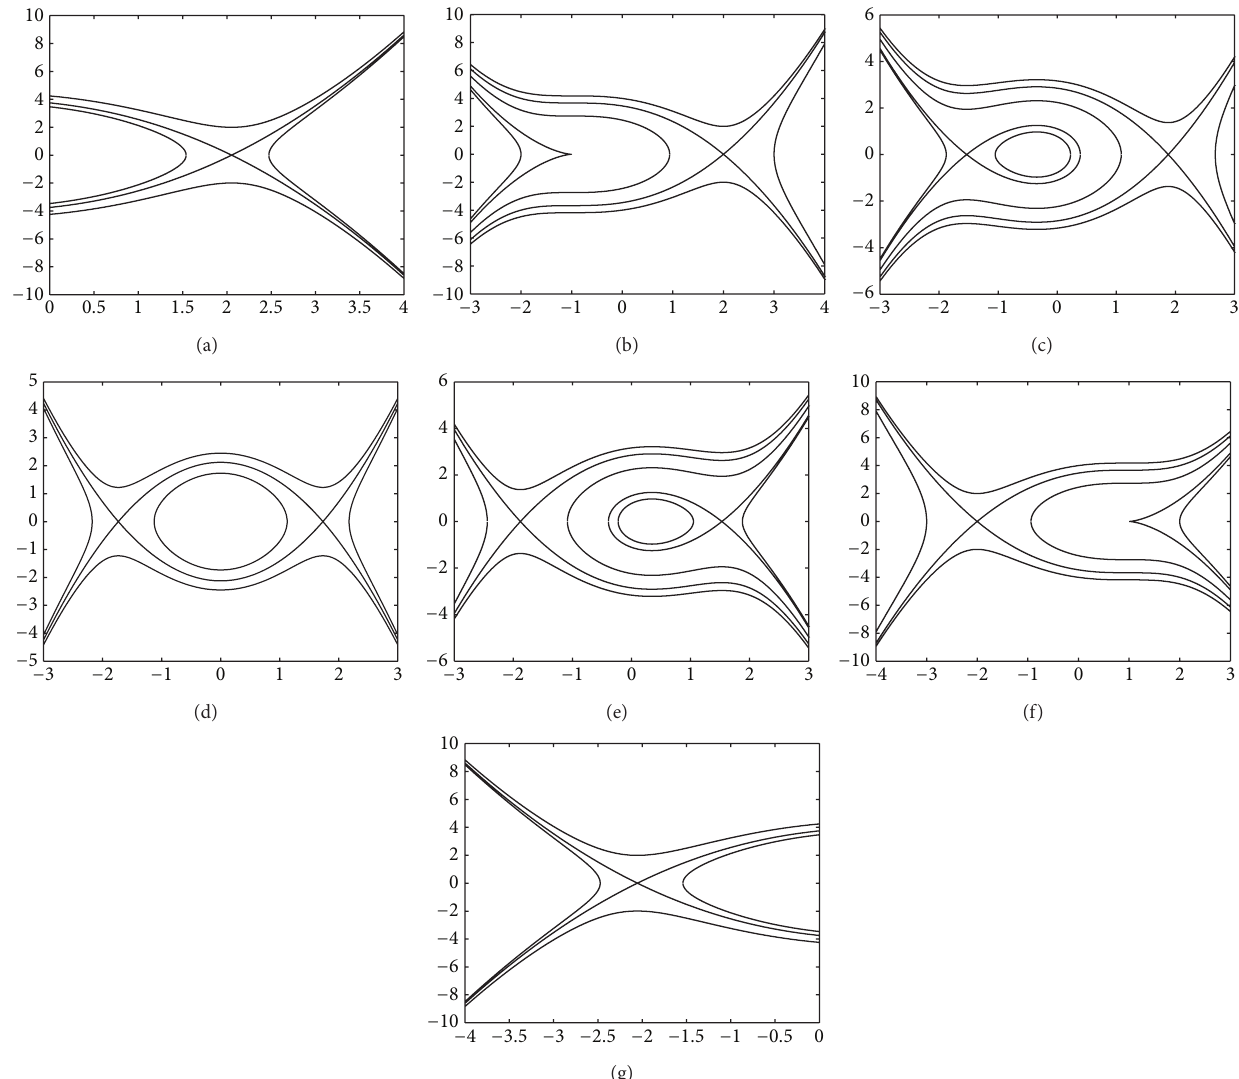
); − 2 (𝑡 = 𝑡 ); −1 (𝑡 < 𝑡 < 𝑡 ) ; 0 (heteroclinic SC 1 SC 1 SC 1 SC 2 ) . ); 2.5 (𝑡 > 𝑡 SC 2 SC 2 = −2, 𝑡 = 2, 𝑦 = −1, 𝑦 = 1 SC 1 SC 2 SC 1 SC 2